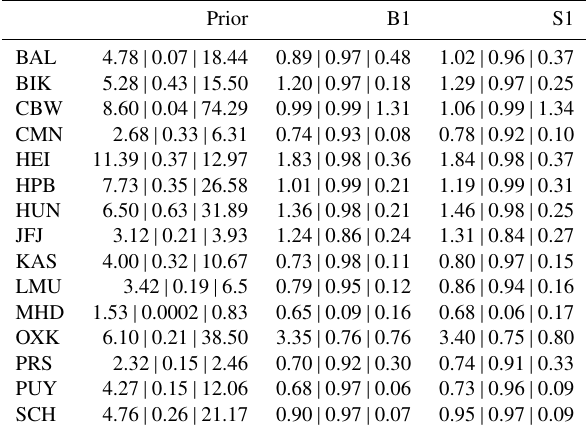
Table 3. RMSD (first column in ppm) and correlation coefficients (second column) between known truth and prior and posterior CO 2 dry mole fractions for daily daytime or nighttime averaged values and for each station. The third column shows χ 2 , the normalized dry mole fraction mismatch per degree of freedom for 7-day averaged residuals, as a measure of how well the data were fitted. The format for each station is as follows: RMSD | r 2 | χ 2